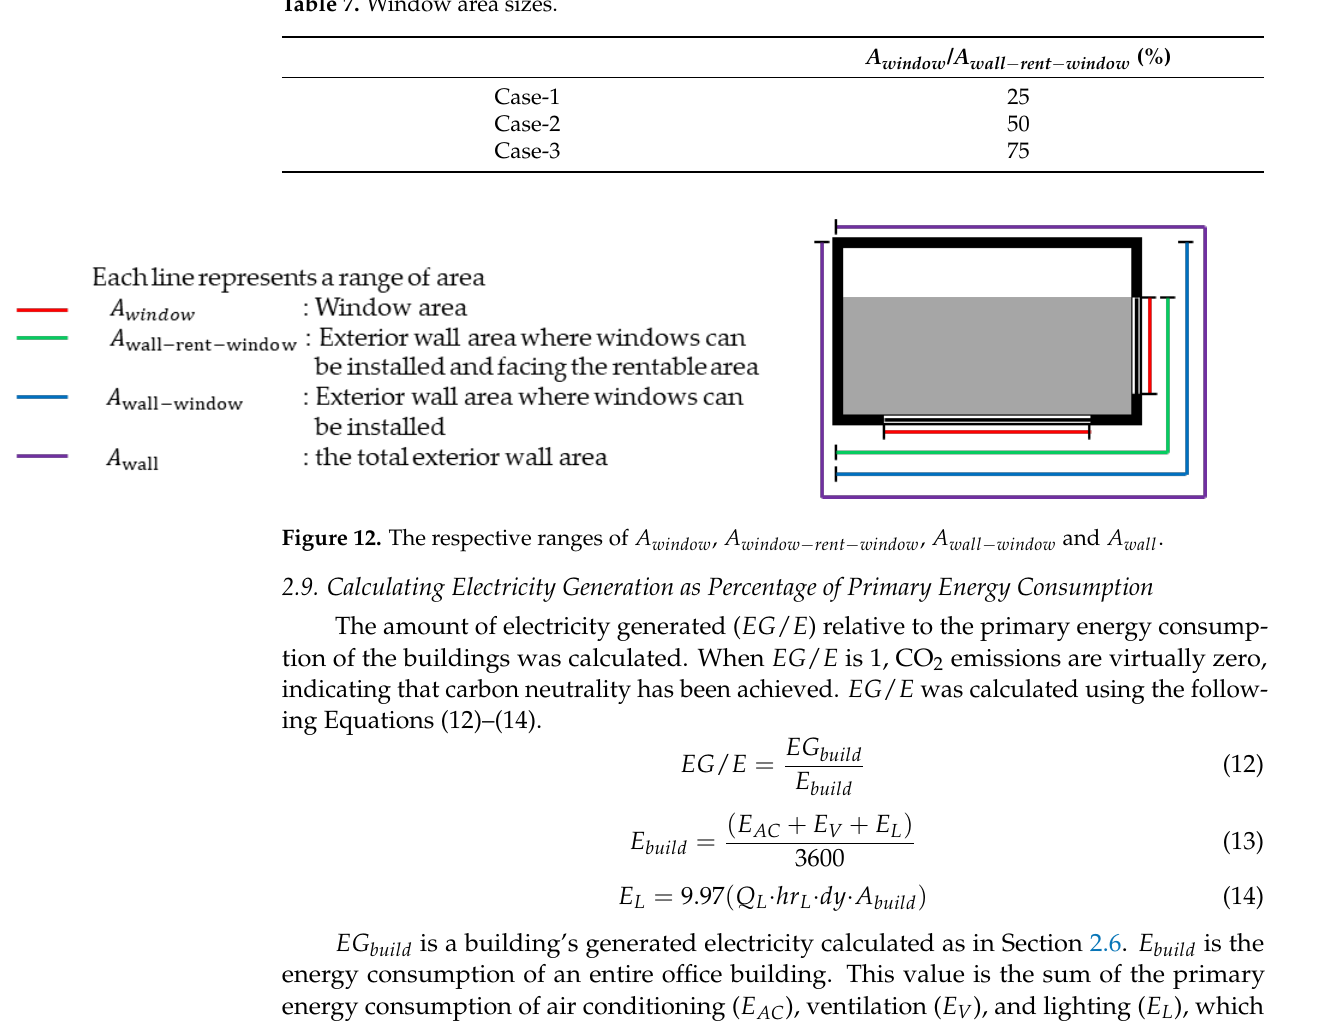
Table 6. Window model. Table 7. Window area sizes.